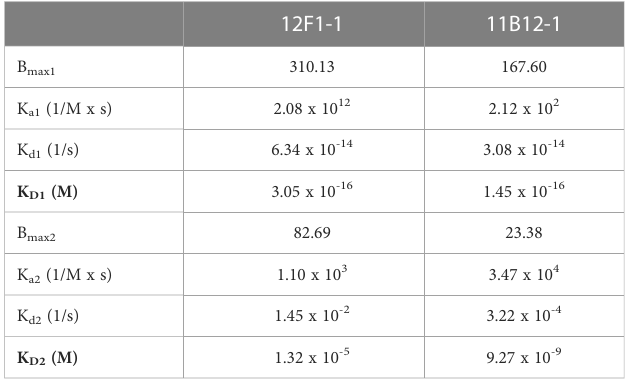
TABLE 1 Surface Plasmon Resonance (SPR) readout for the bivalent interactions of anti-PD-L1 clones 12F1-1 and 11B12-1 with hamster